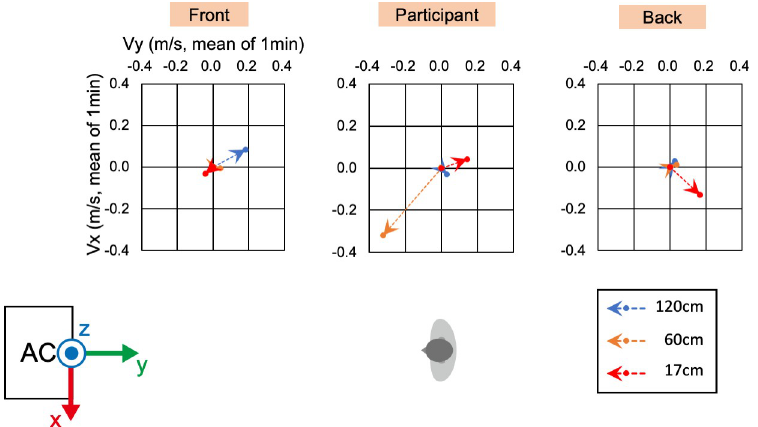
Fig 4. Wind velocity and direction in the X-Y plane of the direct condition. Vx and Vy indicate the mean of the 1-min velocity in the Y or Z direction, respectively. Dotted lines indicate the vectors of the wind velocities.